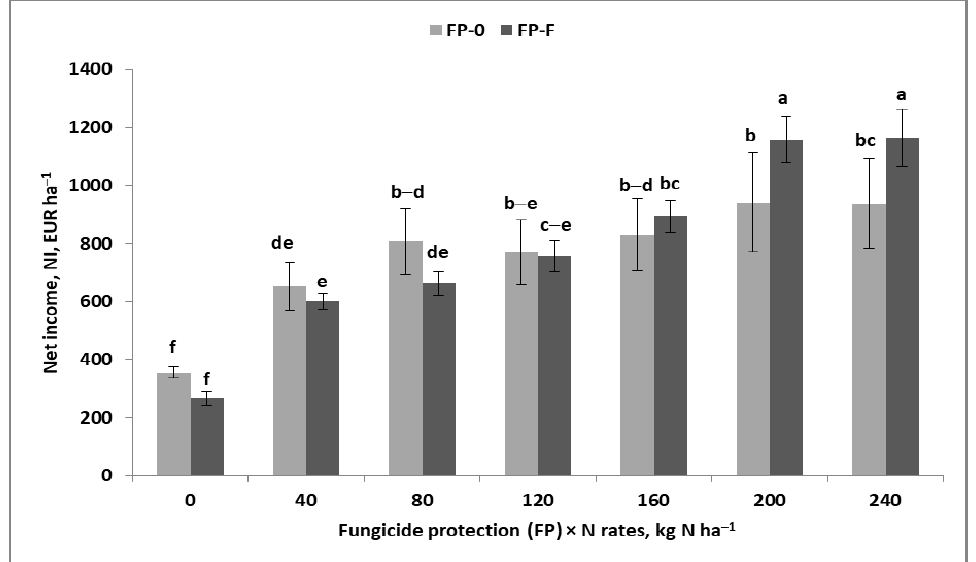
Figure 4. Effect of winter wheat protection with fungicides and rates of fertiliser nitrogen on net income. Similar letters in the column means a lack of significant differences using Tukey’s test; the vertical bar in the column refers to the standard error of the mean.